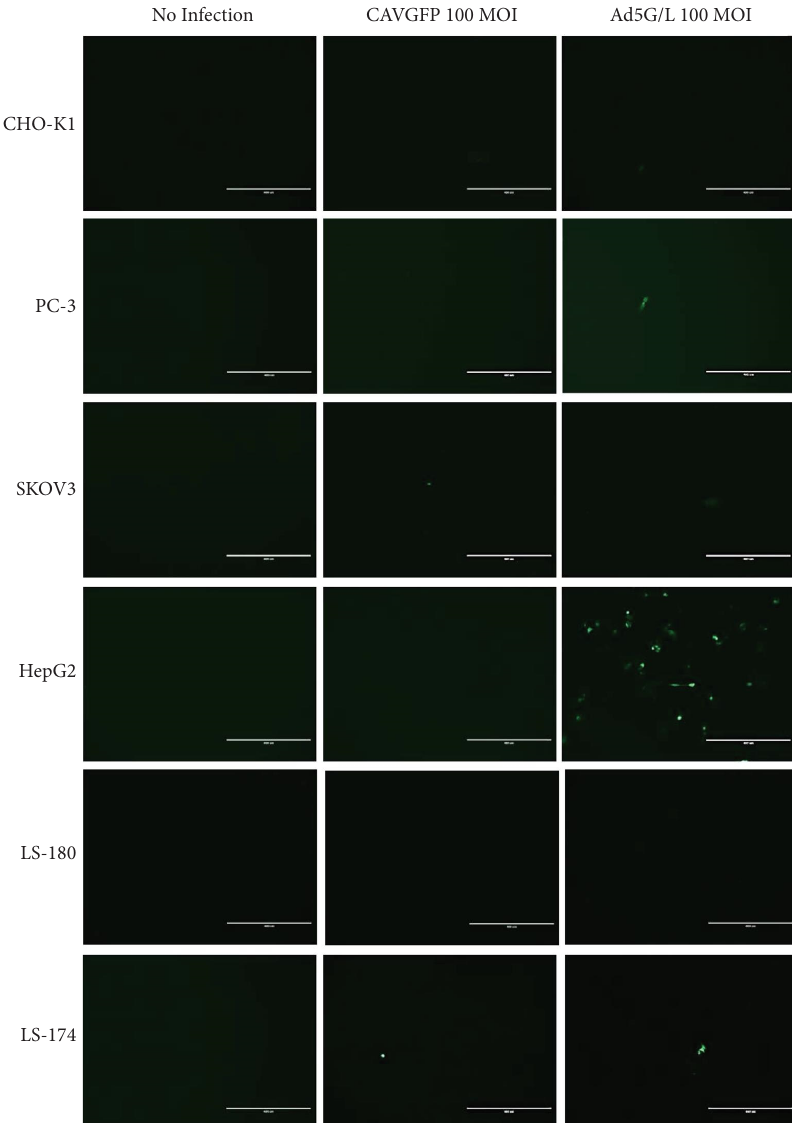
Figure 3: CAVGFP and Ad5G/L directed GFP expression in Chinese Hamster Ovary CHO K1 cells and human cell lines PC3, SKOV3, HepG2, LS 174, and LS 180. Cells were transduced by adenoviruses CAVGFP and Ad5G/L at 100 multiplicity of infection (MOI 100 virus particles per cell). Cells were monitored at 48 hours post infection for green fuorescence using an inverted fuorescent microscope (EVOS FL Cell Imaging System). Tis fgure is a representative of three independent infection